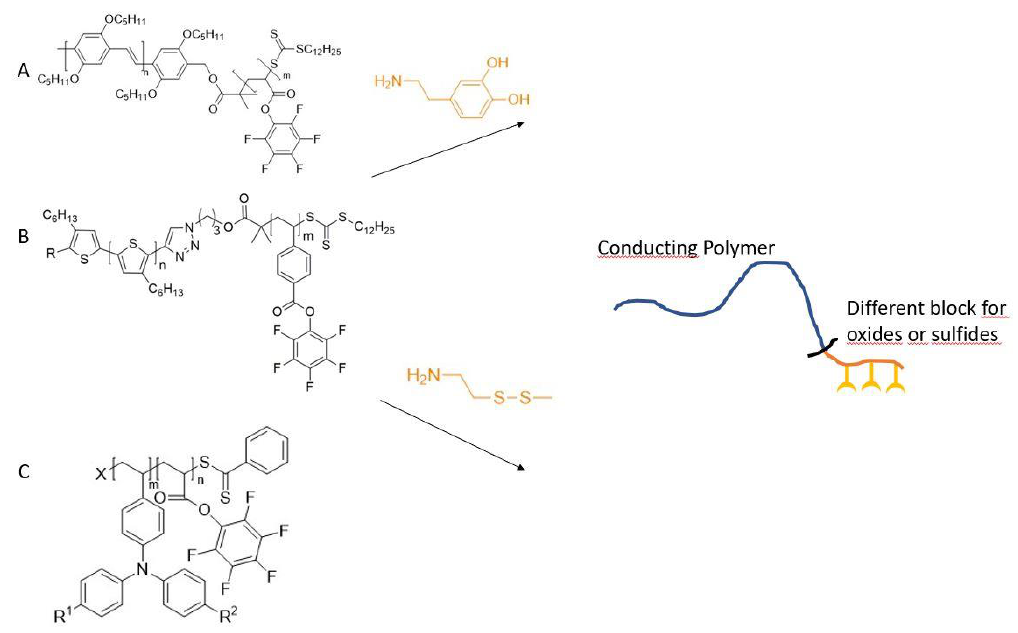
Figure 10. Block copolymers based on polyphenylene-vinylene [116] ( A ), polythiophene [136] ( B ) and polytriarylamine v [134] ( C ) and an anchor block for oxidic or sulfidic quantum dots.